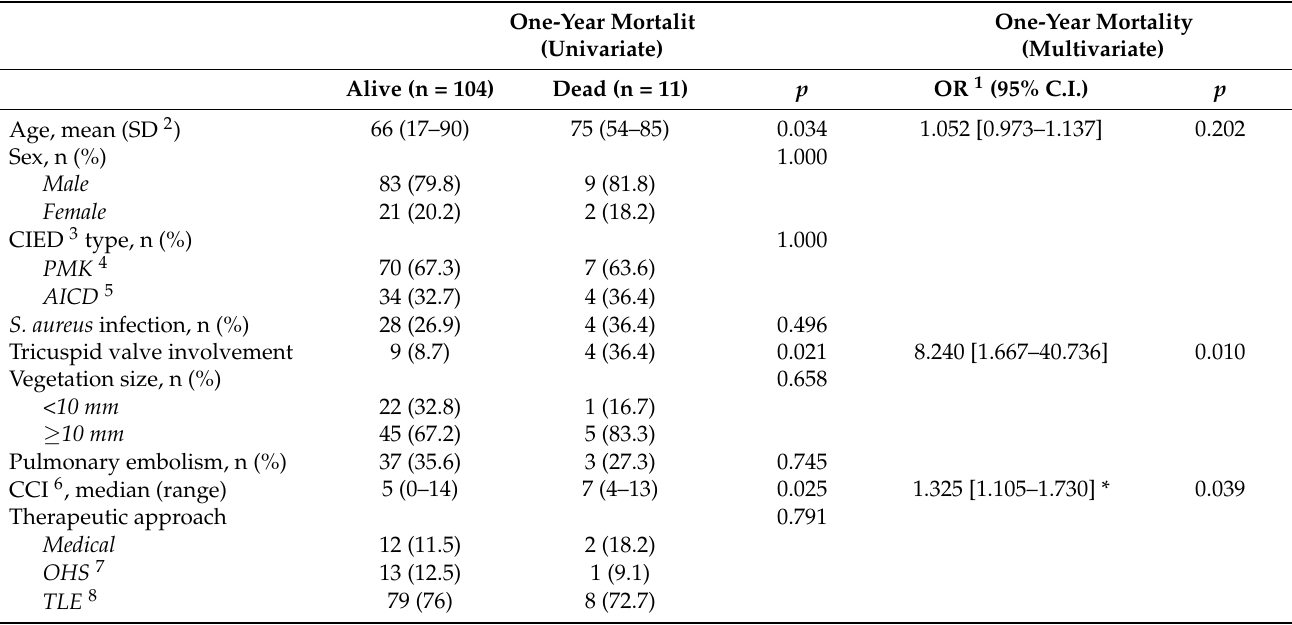
Table 5. Univariate and multivariate analysis of one-year mortality predictors.